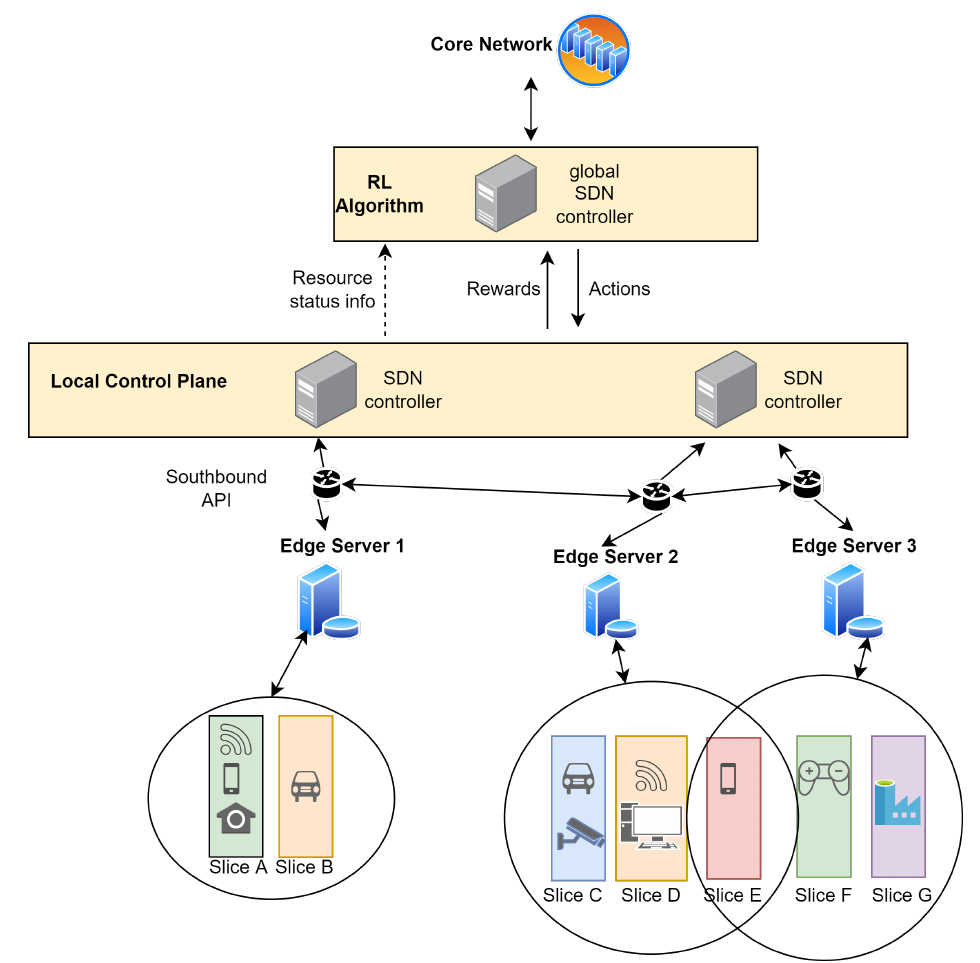
Figure 3. An example system architecture representing proposed research